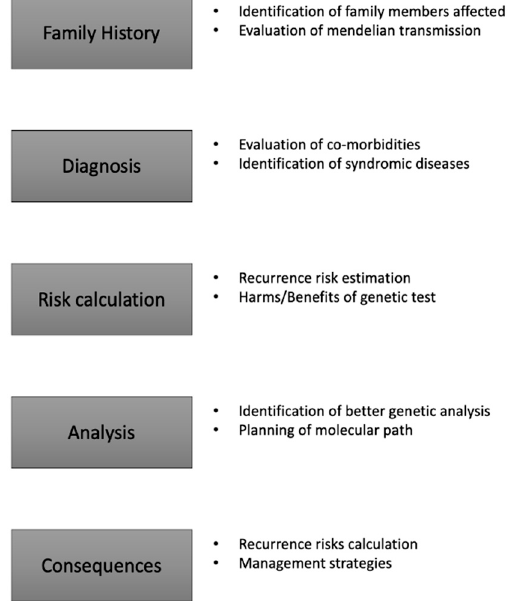
Figure 1. Steps in genetic counselling for neurodegenerative